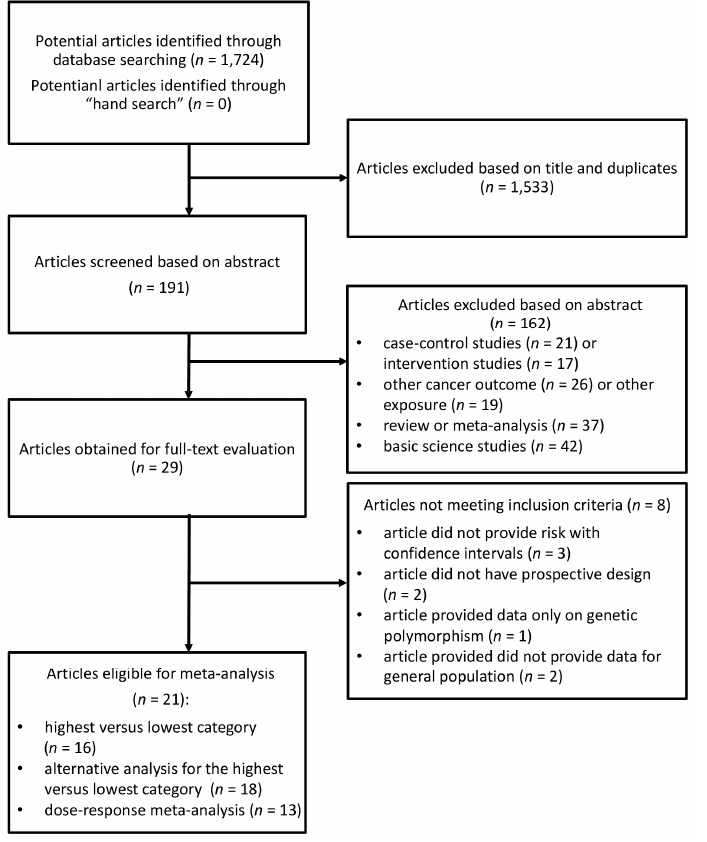
Figure 1. Flow chart of selection of studies reporting on the association between coffee consumption and breast cancer risk.